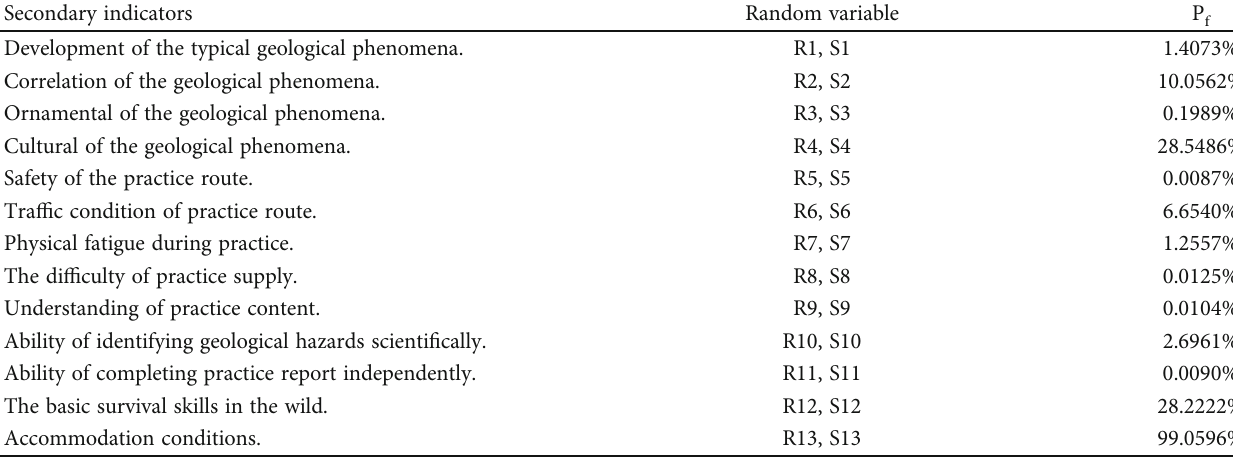
Table 3: Negative evaluation probability of engineering geology practice route with single secondary indicator.